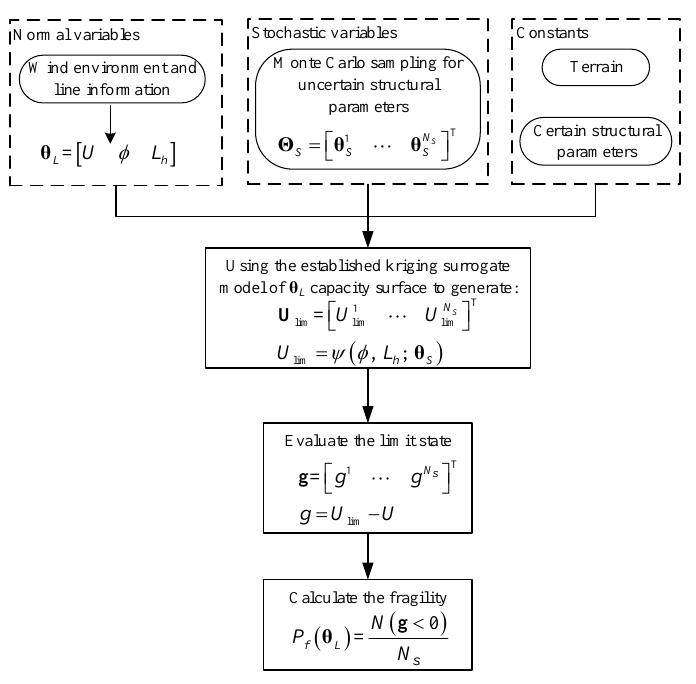
Figure 10. The flow for generating the structural fragility of towers under winds. Depending on the established kriging surrogate model of capacity surface θ L , we can generate multiple groups of fragility curves for the transmission tower with its structural uncertainties considered and the external variables (i.e., the wind environment and line span) involved. Figure 11 further gives the fragility curves of tower ZY achieved by the above flow, in which different wind angles of attack and three horizontal spans are of concern.